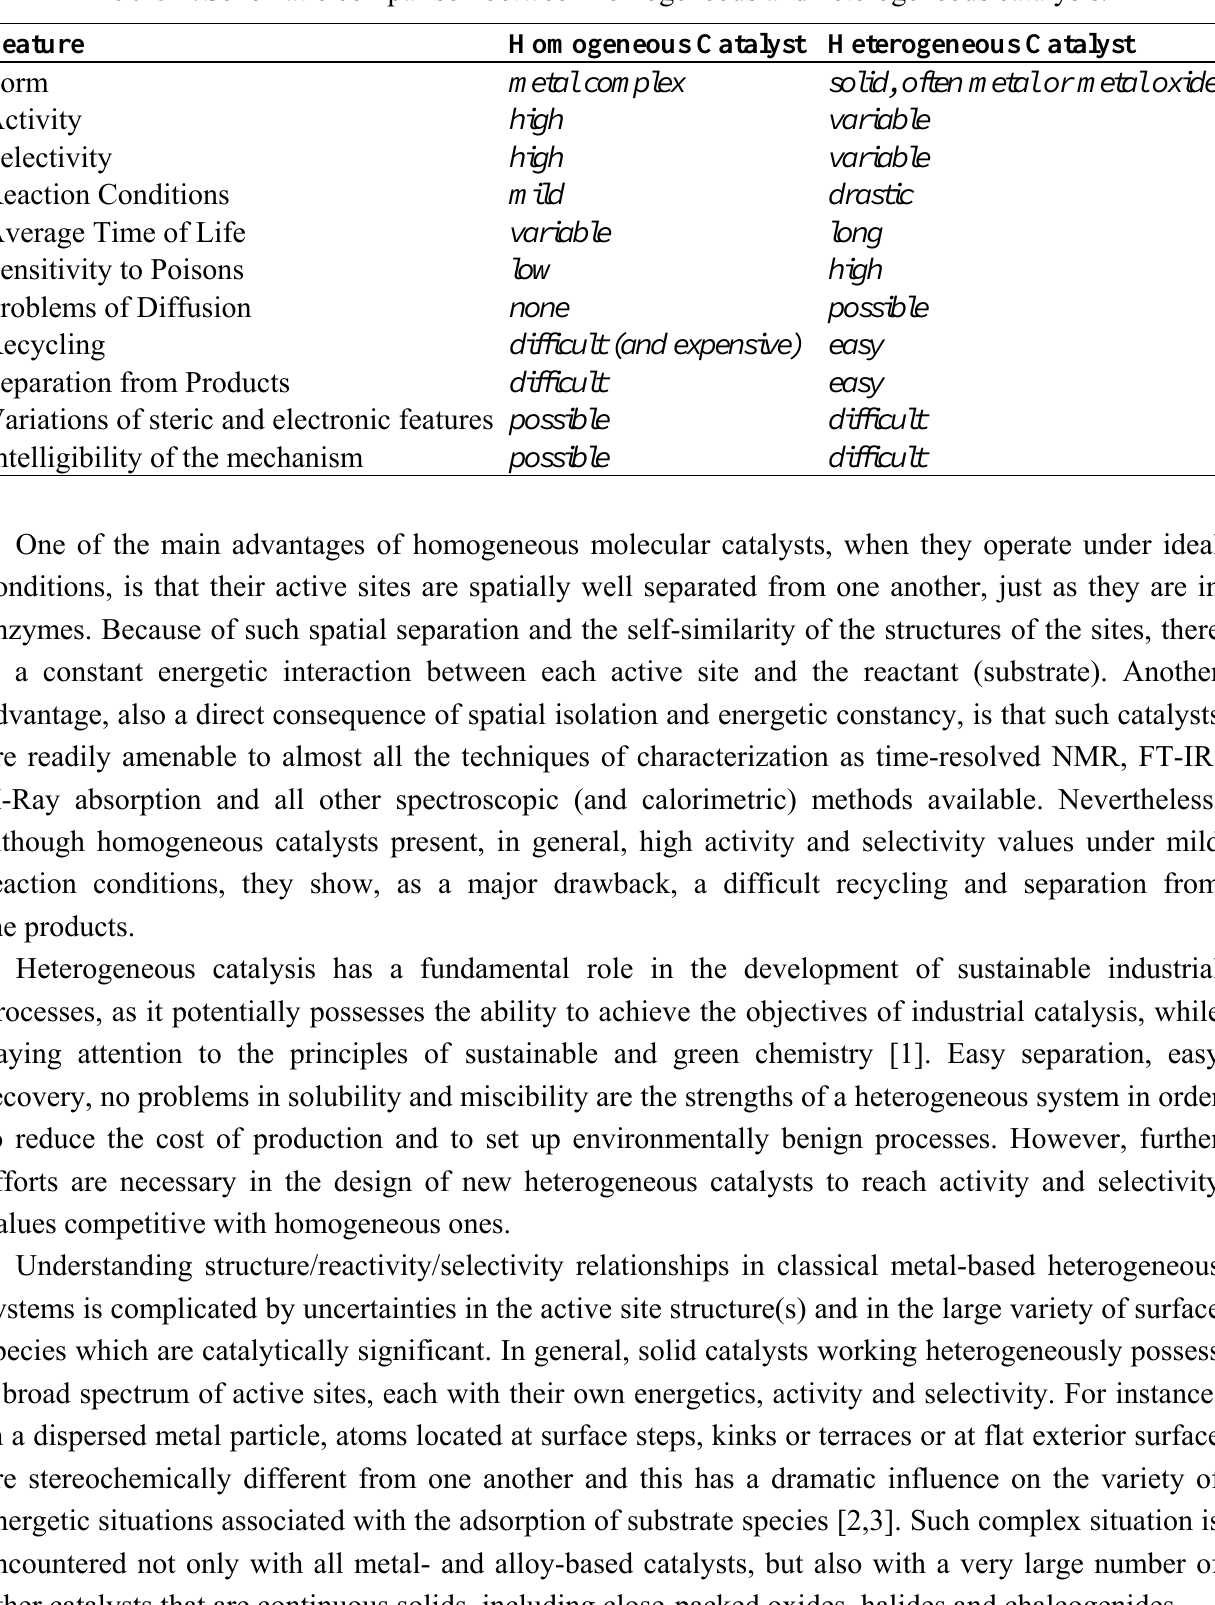
Table 1. Schematic comparison between homogeneous and heterogeneous